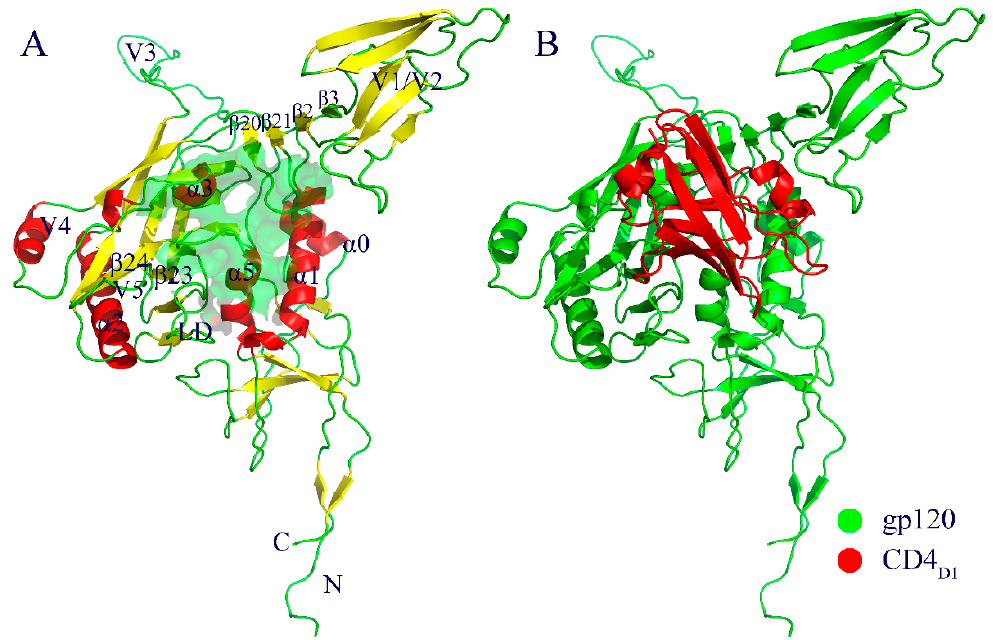
Figure 1. Cartoon representations of the structural models used as starting points for molecular dynamics (MD) simulations. ( A ) CD4-free gp120. ( B ) gp120-CD4 complex. In ( A ), α -helices, β -strands, and loops are colored red, yellow, and green, respectively, and the gp120-CD4 interaction interface is represented as a semi-transparent green surface. In ( B ), gp120 and the CD4 D1 domain (CD4 D1 ) are colored green and red, respectively.